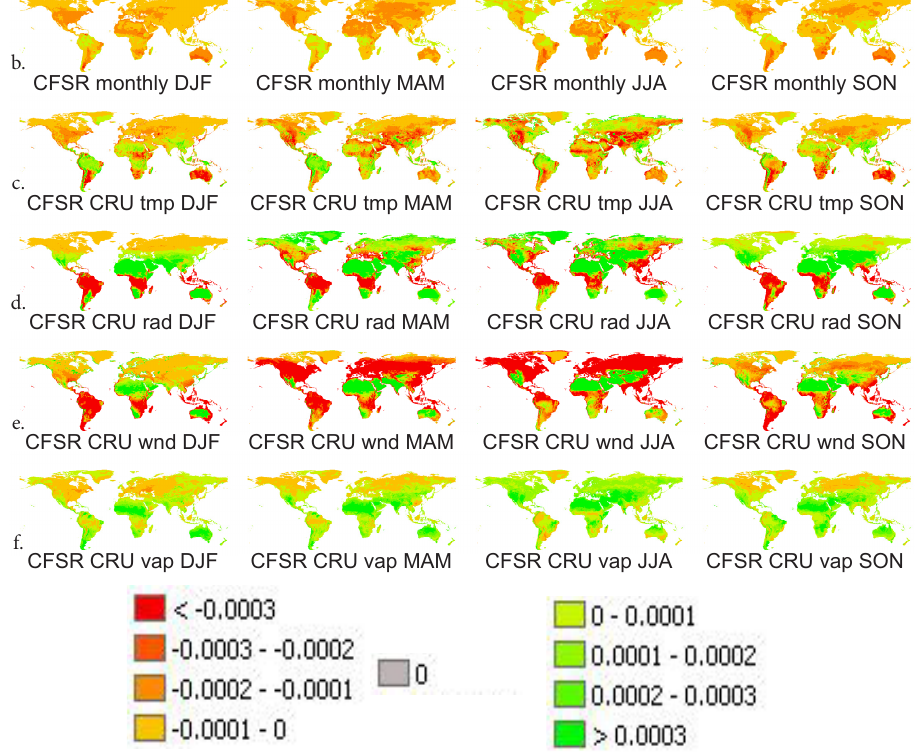
Fig. 2. Global maps with bias of monthly CFSR-CRU derived Penman-Monteith potential evaporation (mday − 1 ) from daily Penman- Monteith potential evaporation calculated from the daily CFSR time-series for all four seasons. From top to bottom: bias for (b) the full CFSR dataset where al input variables are aggregated to a monthly time-step, (c) the CFSR datasets aggregated to monthly values and temperature replaced with CRU TS2.1 values, (d) the CFSR datasets aggregated to monthly values and incoming radiation derived from an annual sinusoidal radiation cycle and the CRU TS2.1 cloud cover, (e) the CFSR datasets aggregated to monthly values and wind from the CRU CL 1.0 dataset, (f) the CFSR datasets aggregated to monthly values and vapor pressure from the CRU TS2.1